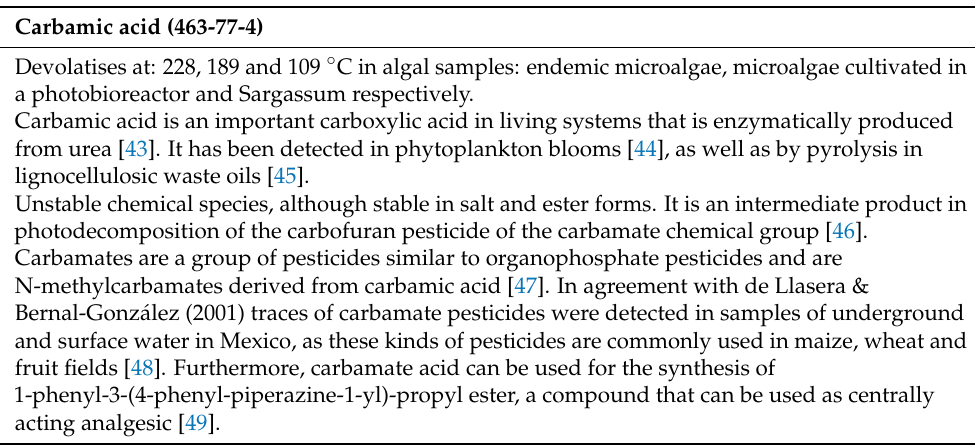
Table 6. Volatile compounds (carboxylic acids) detected in the TG-GC/MS coupling analysis of the algal biomass during